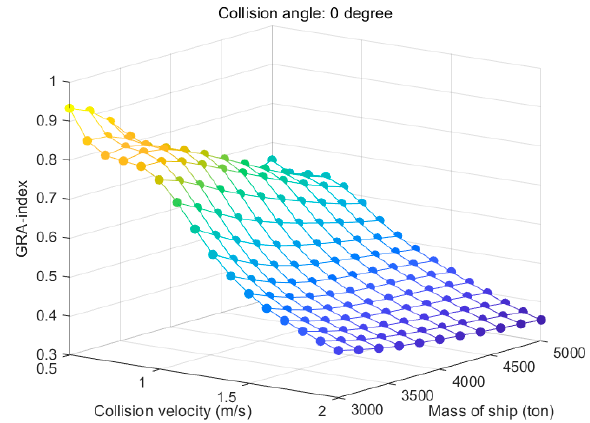
Figure 12. GRA index with regard to collision velocity and mass of ship.